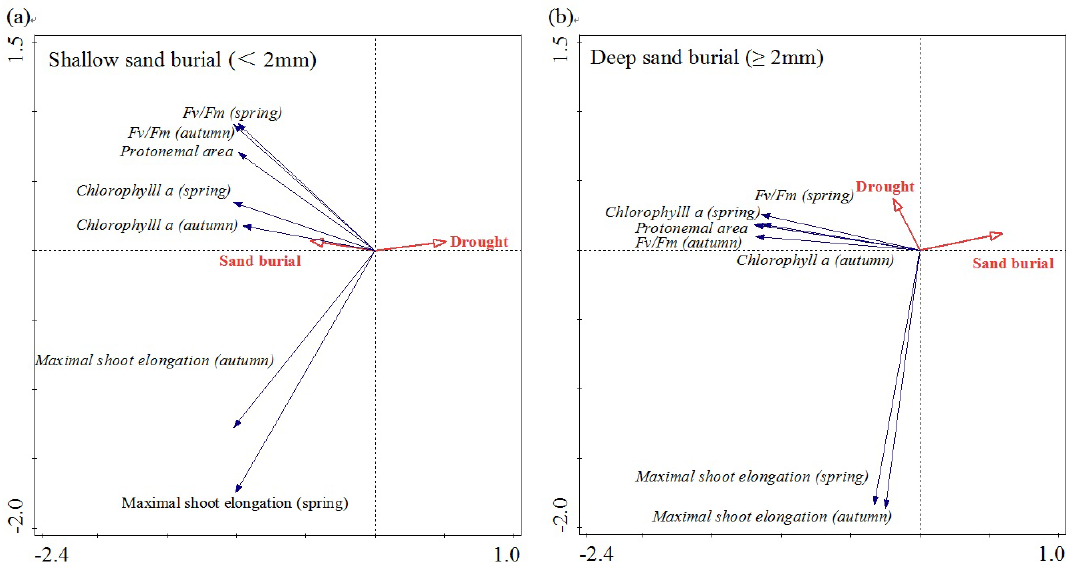
Figure 6. RDA diagram of the effect of drought, sand burial, and their combination on the chlorophyll a content, PSII photochemical efficiency (Fv / Fm), regeneration potential (protonemal area), and shoot upgrowth (maximal shoot elongation) of biocrust moss Bryum argenteum Hedw. Under a shallow sand burial treatment, the eigenvalues were 0.8134 and 0.0152 for the first and second axes, respectively, and the correlation coefficients were 0.9527 and 0.4876, respectively. In terms of deep-sand burial, the eigenvalues of the first and second axes were 0.6068 and 0.2379, respectively, and the correlation coefficients were 0.9362 and 0.9126, respectively. The Monte Carlo permutation test indicates that all variables were significantly correlated with the environmental factors ( p < 0 .